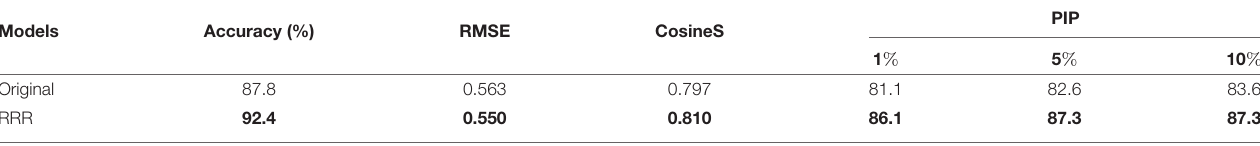
TABLE 3 | Accuracy and explanation assessment for the task of classifying plant species. Models